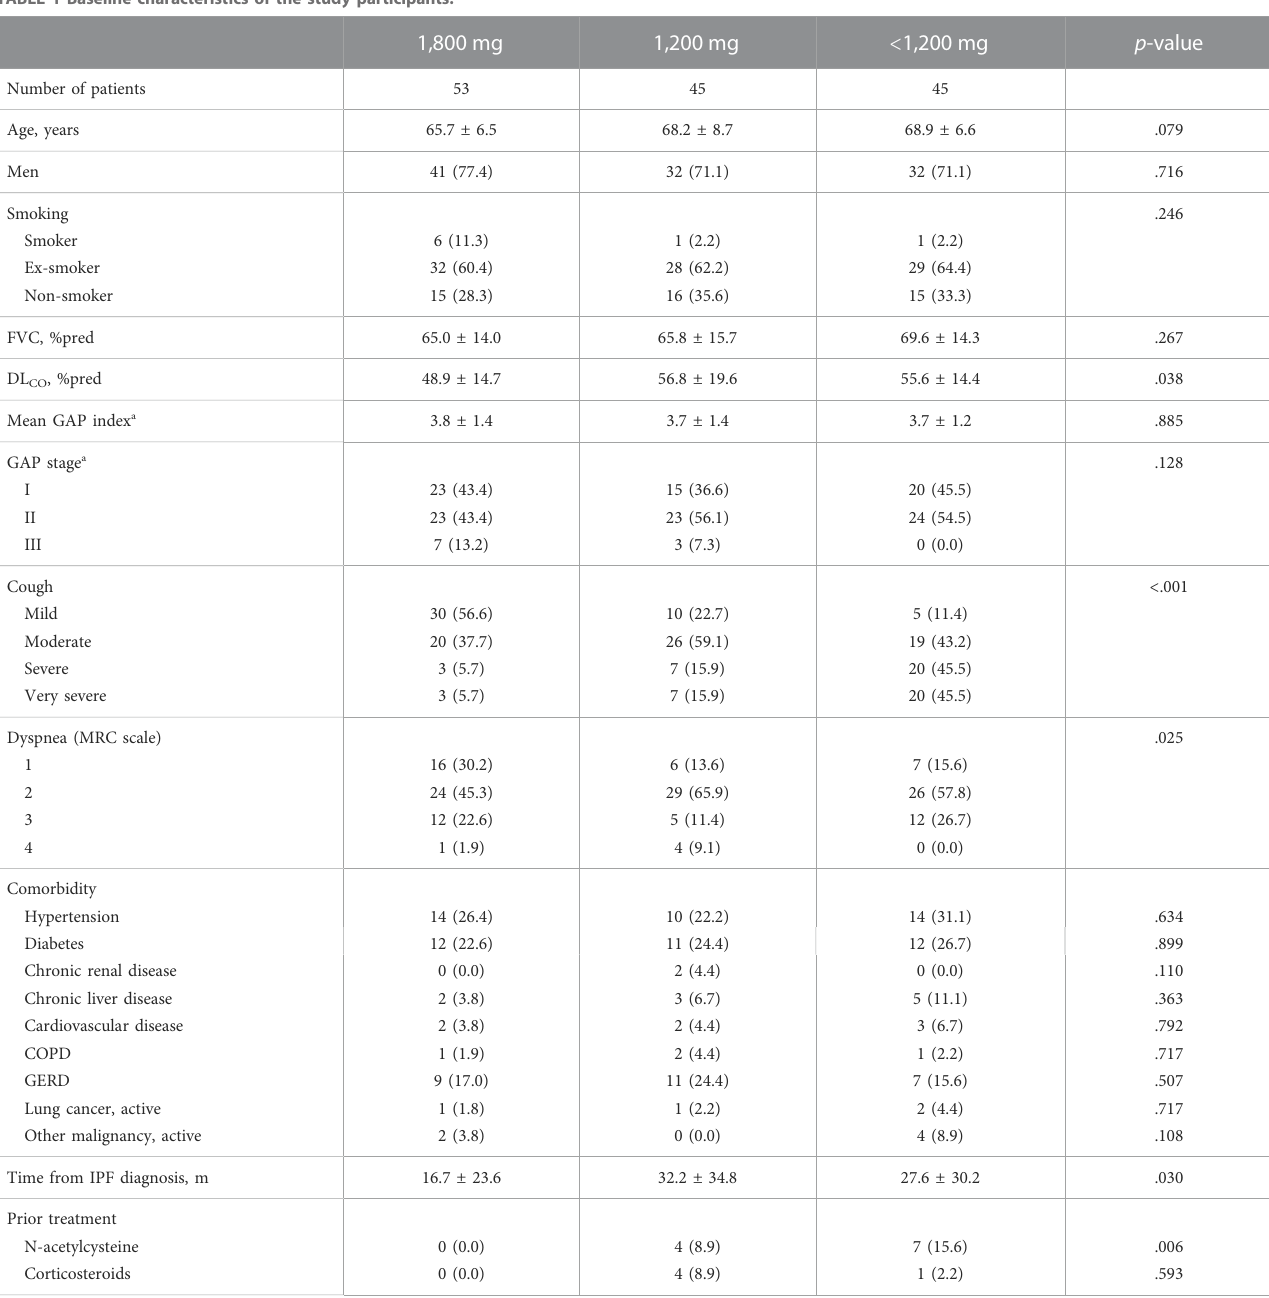
TABLE 1 Baseline characteristics of the study